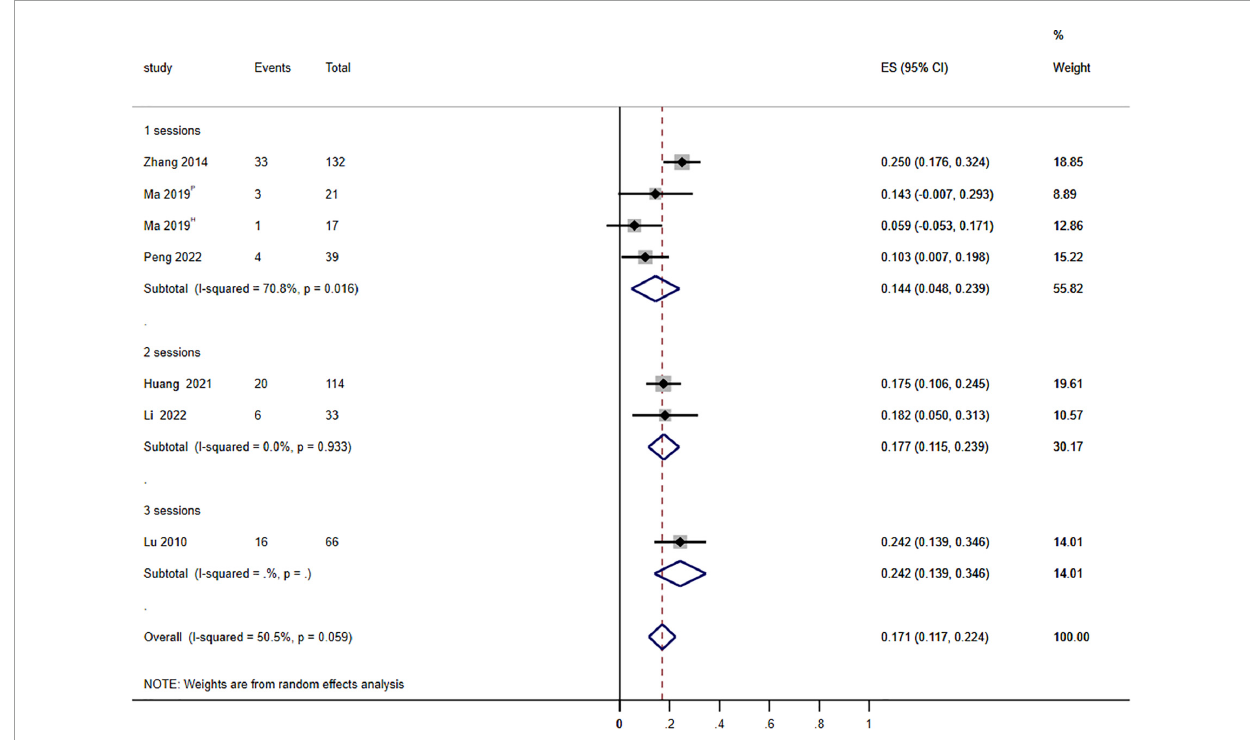
FIGURE3 Forest plot of the effects of photodynamic therapy (PDT) on treatment sessions ( ≥ 75% improvement). P: PsD-007-PDT; H: HMME-PDT. Weights are from random effects analysis.